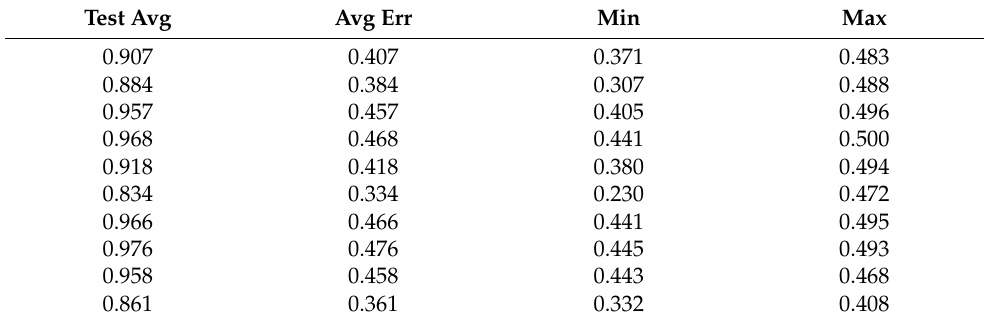
Table A101. Set 2, trials 11–20 data (all 0.5 PR values).